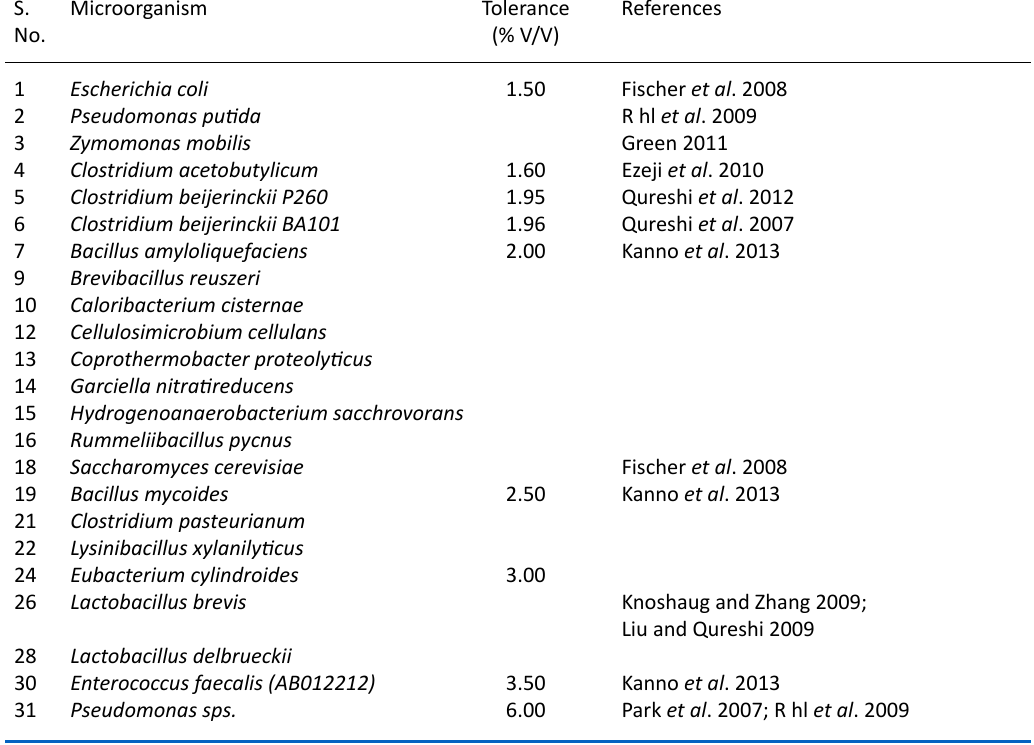
table 3. Percentage tolerance of microbial isolates for next-generation biofuel butanol S. Microorganism